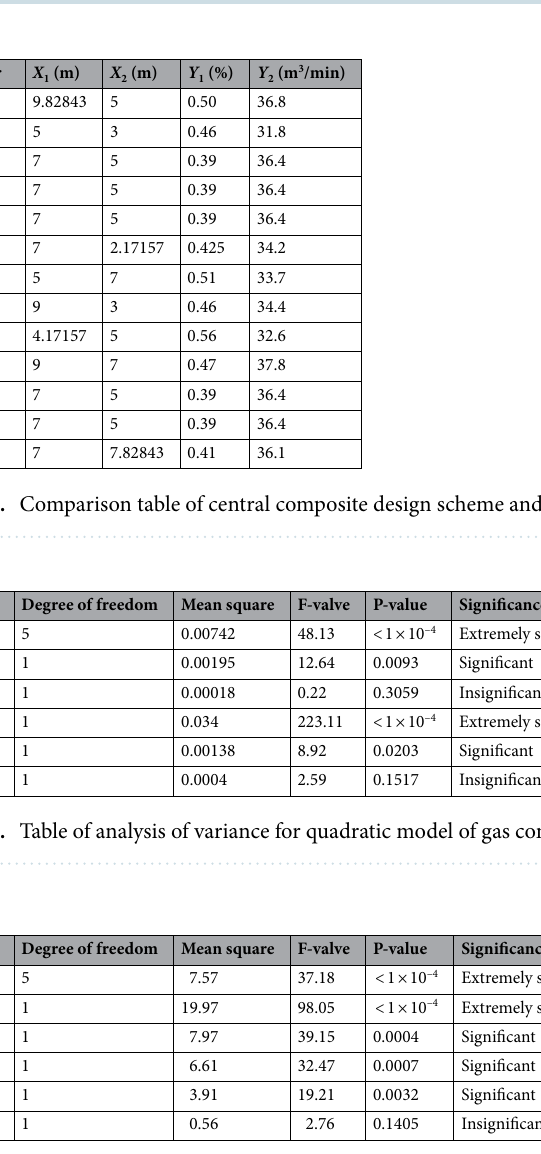
Table 5. Table of analysis of variance for quadratic model of gas drainage volume in the roof low roadway.